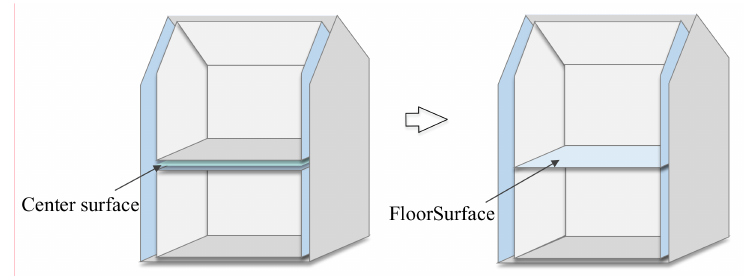
Figure 11. Simplification of ceilings and